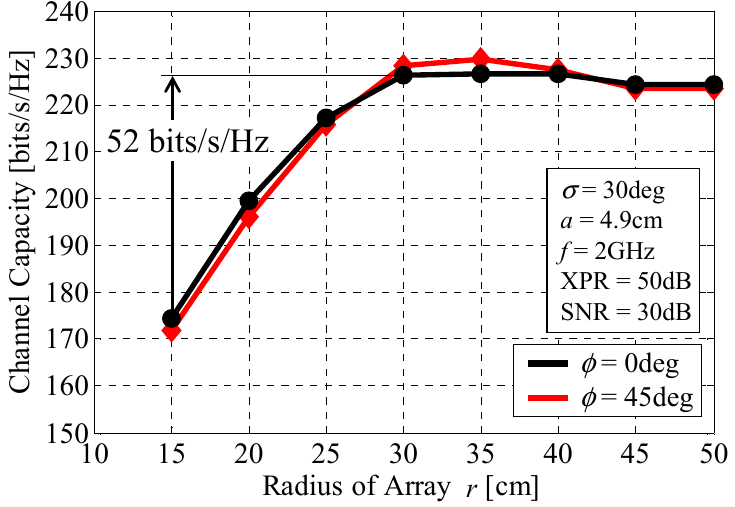
Figure 12. Channel capacity as a function of the radius of the array.